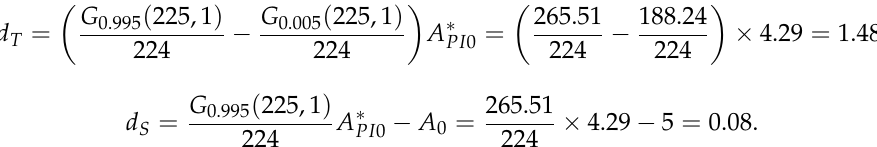
Figure 3. The membership function ( ) x η with vertical line 5 x = .